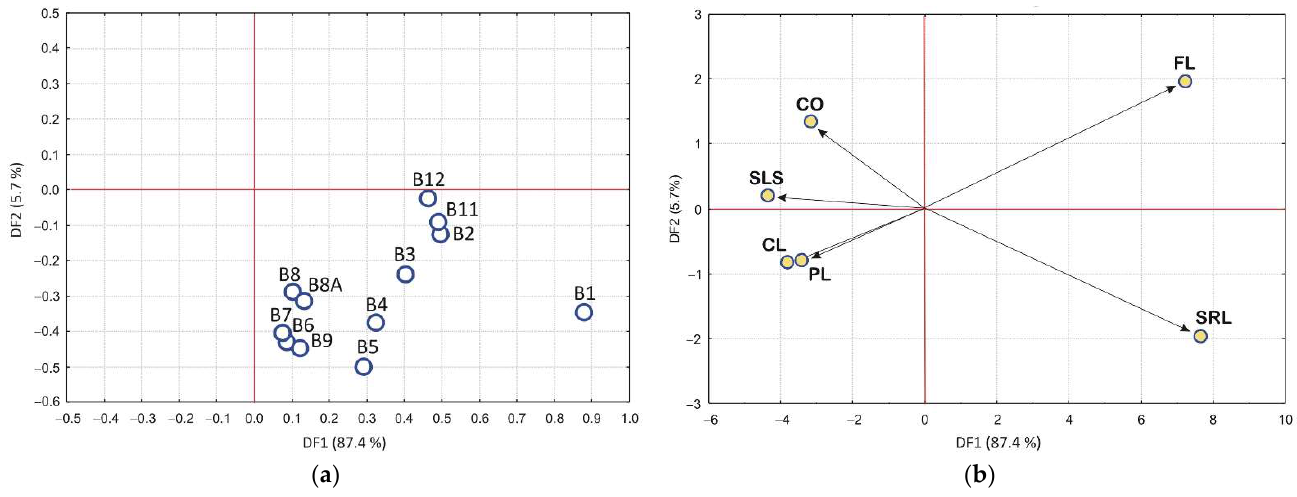
Figure 13. ( a ) Scatterplot of variable loadings, bands B1 to B12; ( b ) scatterplot of group means of six lithological units (SRL, FL, CO, PL, CL, SLS).